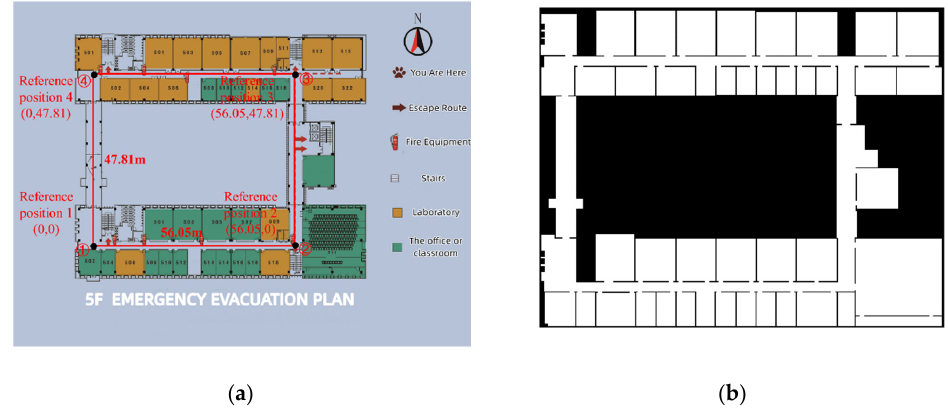
Figure 5. In Figure 5a, the red line indicates the corridor path. The four black dots ( ①②③ ④ ) represent the reference point of the relative position.